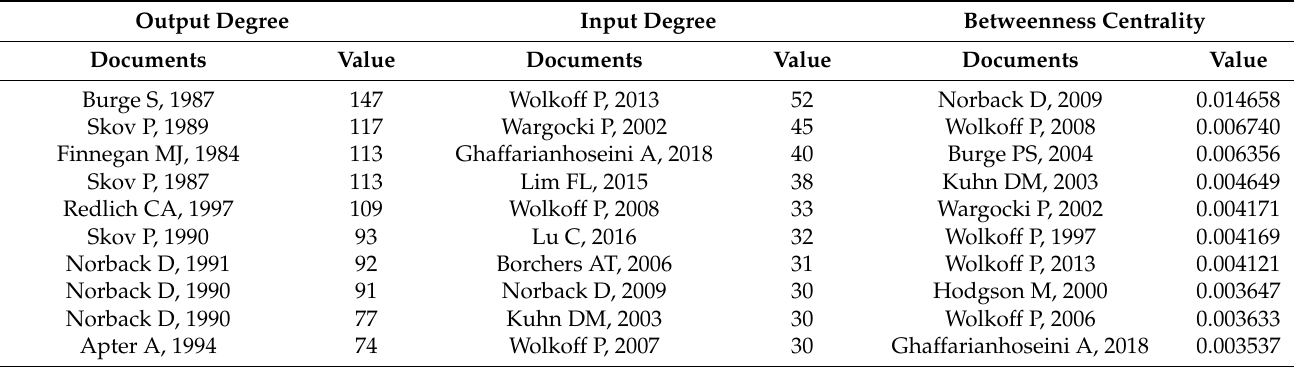
Table 2. Parameter information of nodes in the citation network.